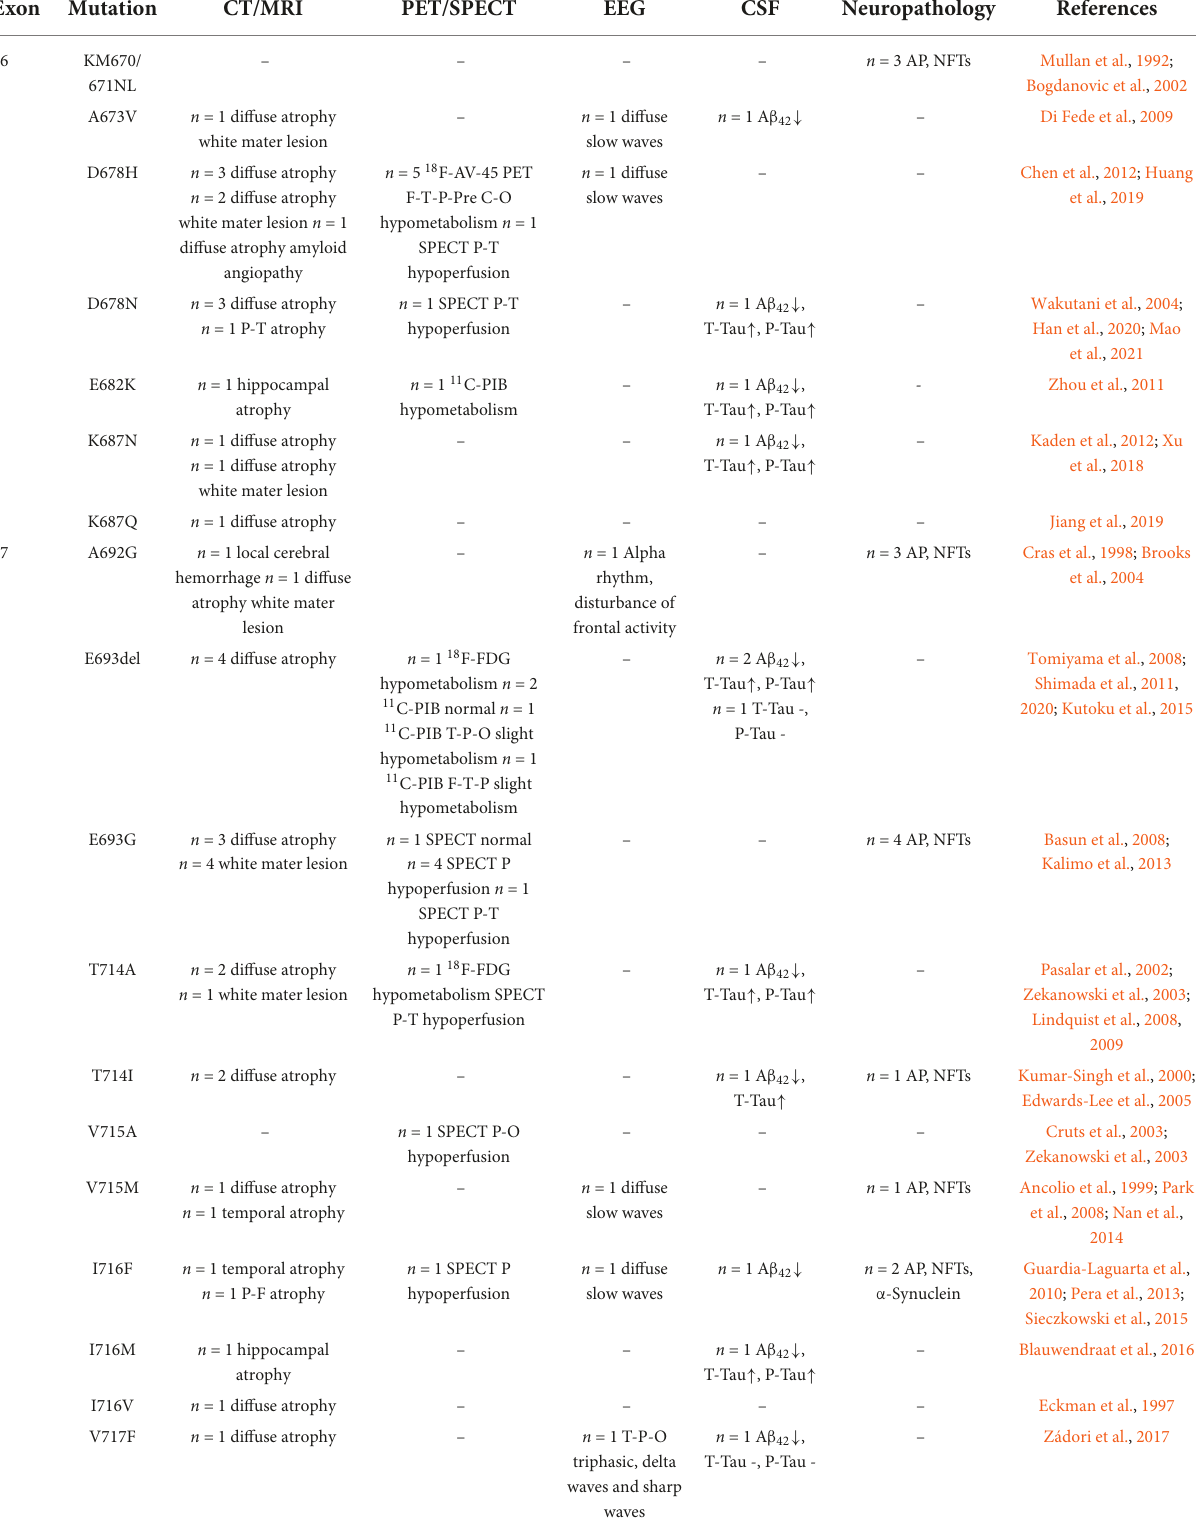
TABLE 1 Neuroimaging, electroencephalography, cerebrospinal fluid (CSF) analysis, and neuropathology findings in pathogenic/likely pathogenic amyloid protein precursor ( APP ) mutations.